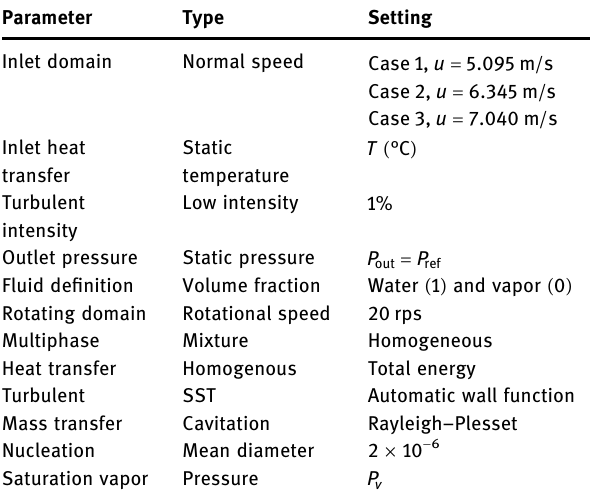
Table 4: Numerical cavitation test